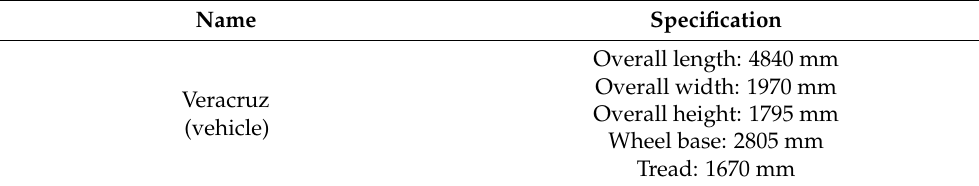
Figure 14. Test vehicle. Table 2. Specifications of the test vehicle.